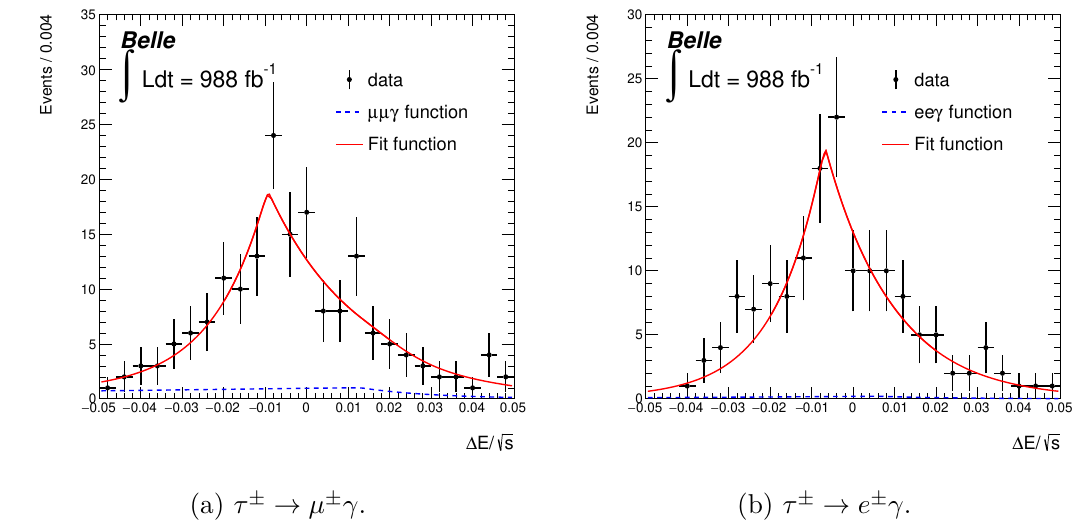
√ Figure 5 . ∆ E/ s distribution in the sideband. The black points with error bars are the data and red curves show the fit result of the background